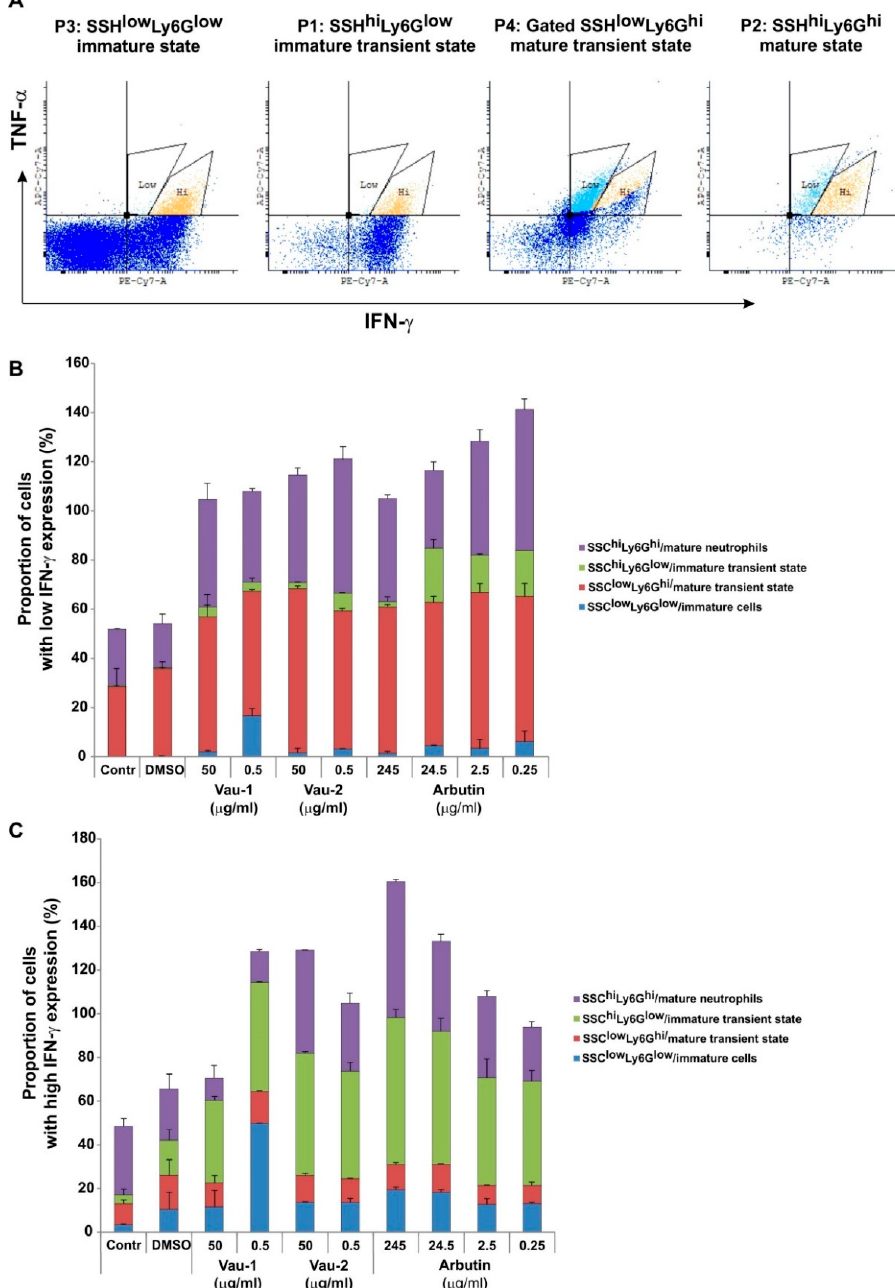
Figure 5. Effect of Vau-1/Vau-2 extracts or arbutin on the frequency of double TNF- α + /IFN- γ + producers within the pool of immature and mature neutrophils in BM. ( A ) Representative dot-plot histograms showing two populations of double TNF- α + /IFN- γ + producers in the control group: TNF- α + /IFN- γ low and TNF- α + /IFN- γ hi which varied in frequency in immature, mature or transient immature or mature pools; ( B ) Proportion of TNF- α + /IFN- γ low neutrophils (in %) at various maturation state in BM cell cultures incubated in the presence or absence of Vau-1, Vau-2 or arbutin for 36 h. Data represent mean ± SD of sample from 2 experiments with neutrophils isolated and pooled from 7 mice and assayed in triplicate; ( C ) Proportion of TNF- α + /IFN- γ hi neutrophils (in %) at various maturation state in BM cell cultures incubated in the presence or absence of Vau-1, Vau-2 or arbutin for 36 hrs. Data represent mean ± SD of sample from 2 experiments, with neutrophils isolated and pooled from 7 mice and assayed in triplicate.